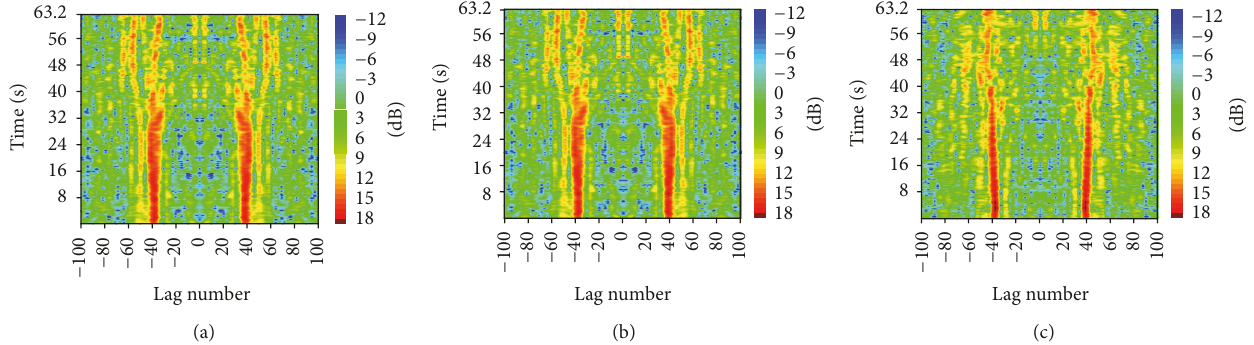
Figure 15: Power spectra of the spatial correlations of the texture: (a) Sum channel. (b) Elevation difference channel. (c) Azimuth difference channel.